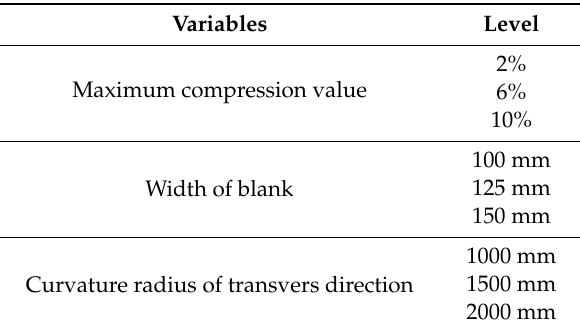
Table 1. Levels of the design